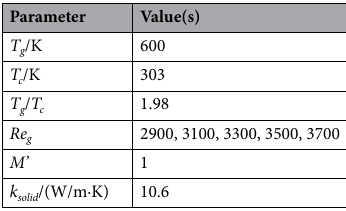
Table 6. Boundary conditions.